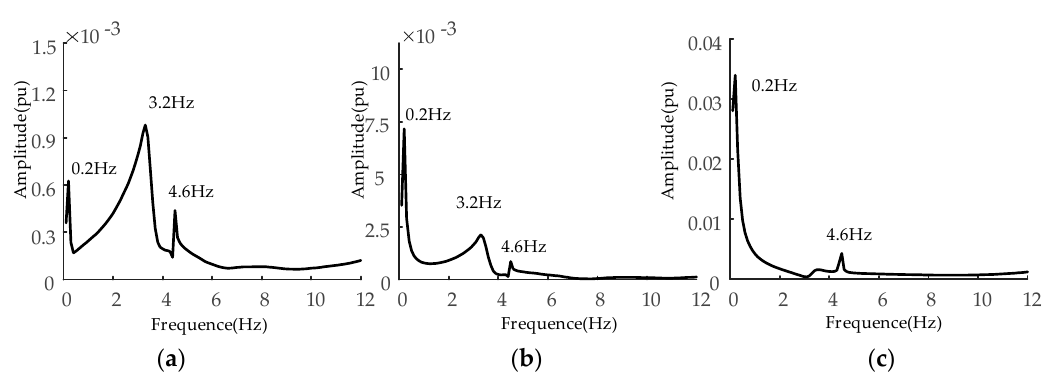
Figure 12. Impact of the three-phase ground fault in the Base case ( a ) Rotational speed ( b ) Electromagnetic torque ( c ) Mechanical torque.